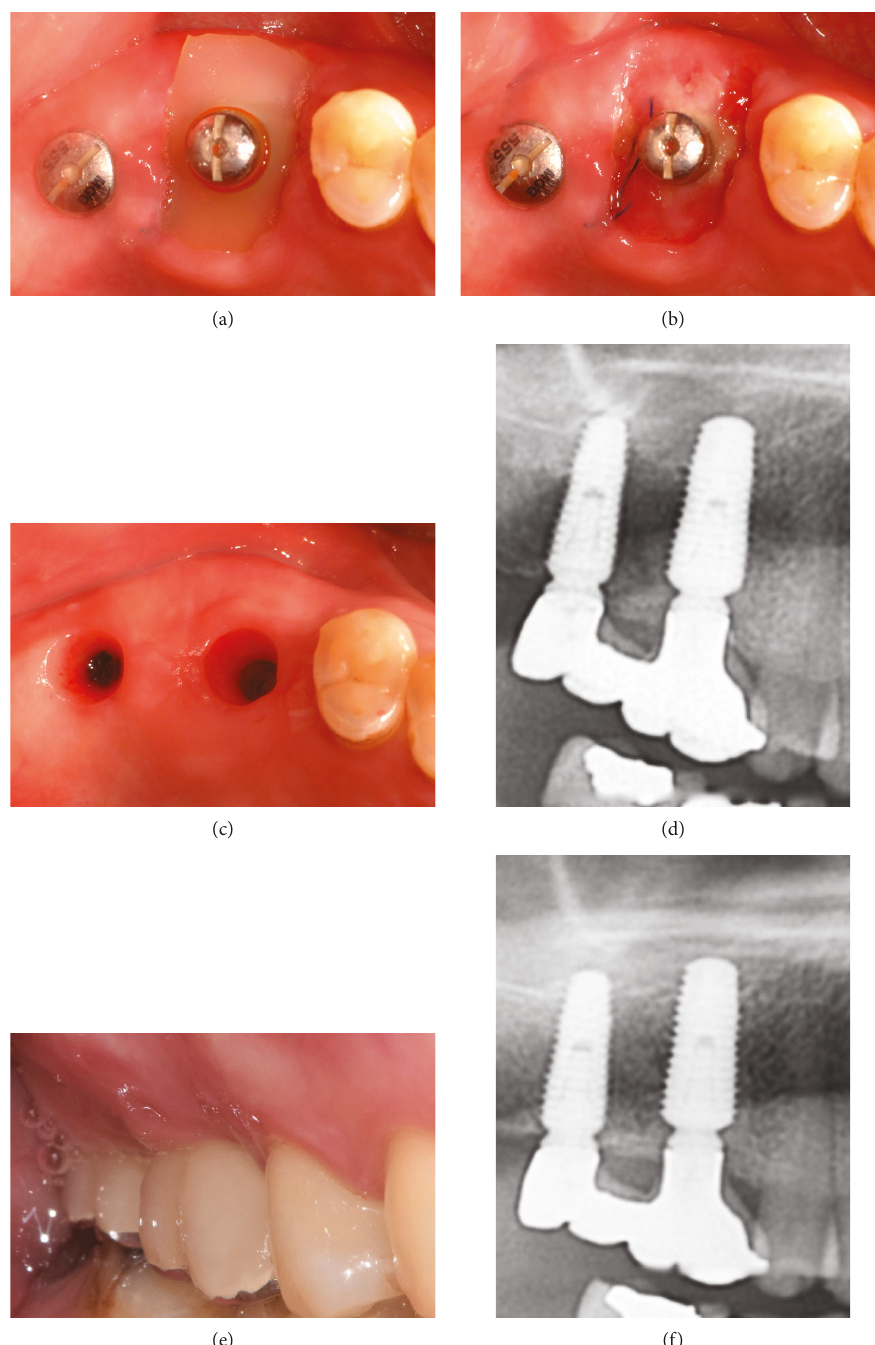
Figure 5: (a) Clean silicone cap at 2 weeks postoperatively. (b) Healing condition of the extraction socket at 2 weeks postoperatively. (c) Clinical condition before the application of the fi nal prosthesis at 8 months after surgery. (d) Radiograph taken after the application of the fi nal prosthesis at 8 months after surgery. (e) Buccal view at 2 years after surgery. (f) Radiographic view at 2 years after